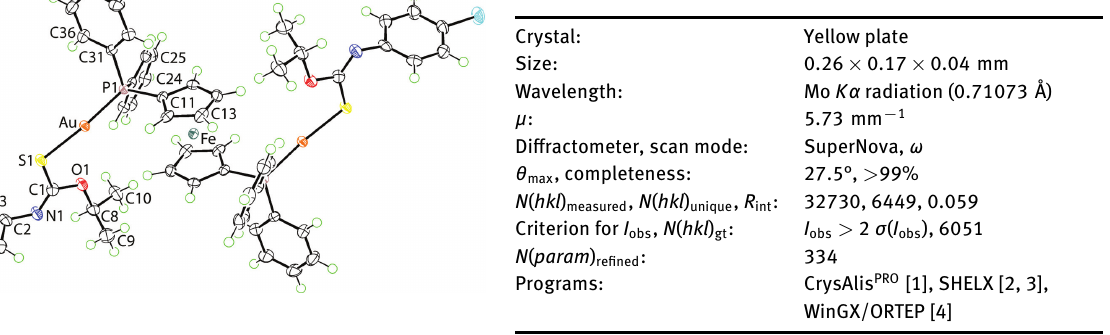
Table 1: Data collection and